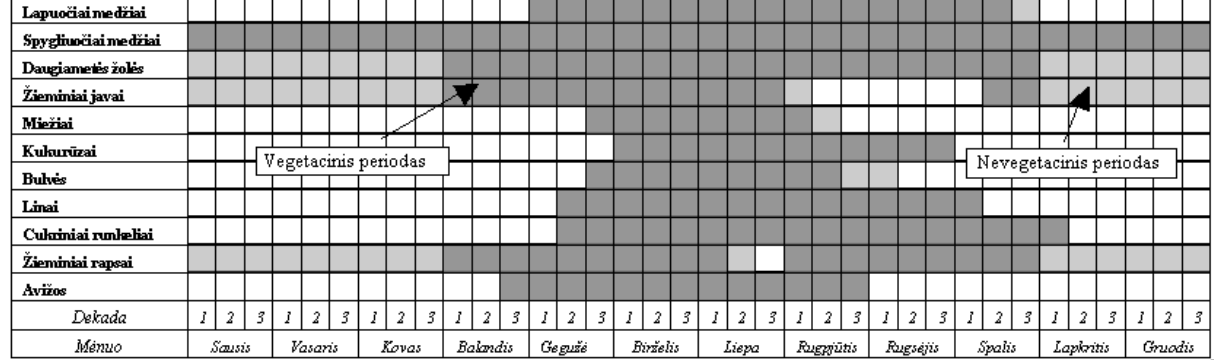
Fig 1 . Vegetation and non-vegetation periods of the plants Vienas